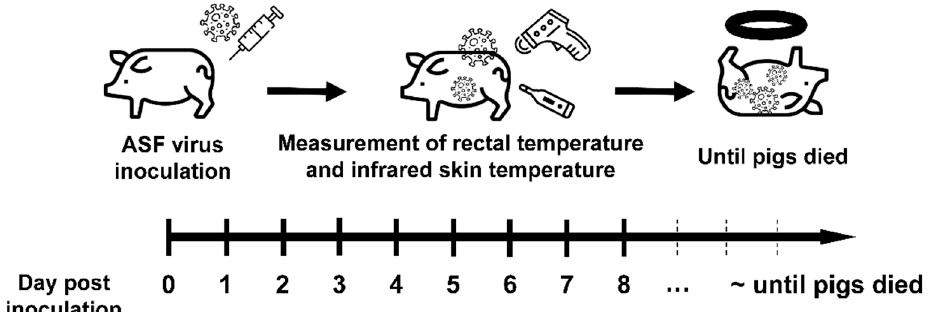
Figure 1. Experimental scheme for the study. The pigs ( n = 10) were inoculated with ASF virus strain (10 3.5 HAD 50 /mL) from Vietnam, and the rectal and infrared skin temperatures were measured for seven pigs once a day until the pigs